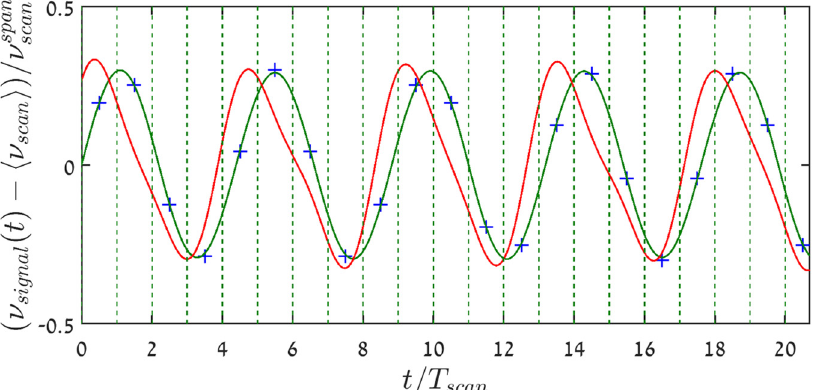
Figure 5. The sinusoidal green curve represents sinc-based reconstruction of the signal from { ˆ s n , ˆ τ n } 549 , where { ˆ s n } 549 are the spline-interpolated signal values on the computable uni- form time grid { ˆ τ n } 549 , Equation (4). The blue pluses (+) represent a few values of the original sinusoidal signal, and their very tight proximity to the recovered green curve attests to the high quality of the reconstruction. The red curve is the one from Figure 2, representing sinc-based reconstruction from { s n } N − 1 , being attributed to the uniform time grid at the start of the scans.